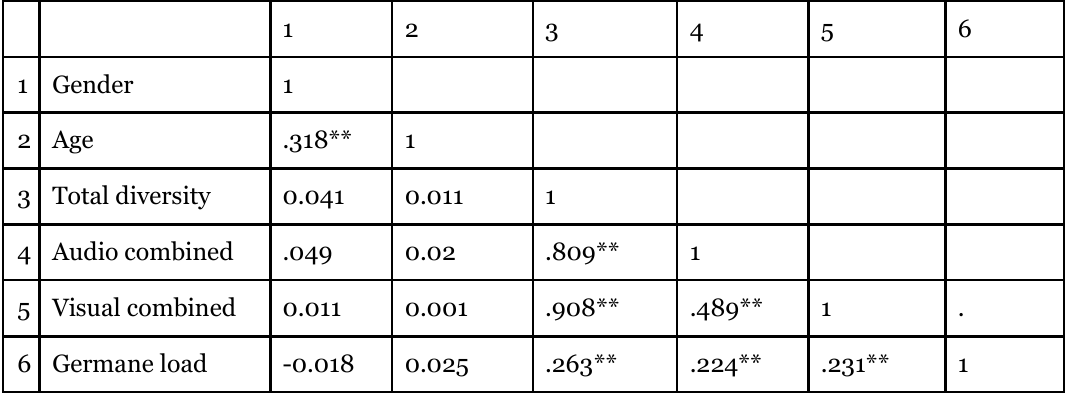
Correlations between Diversity Constructs and Germane Load (N = 1602) 1 2